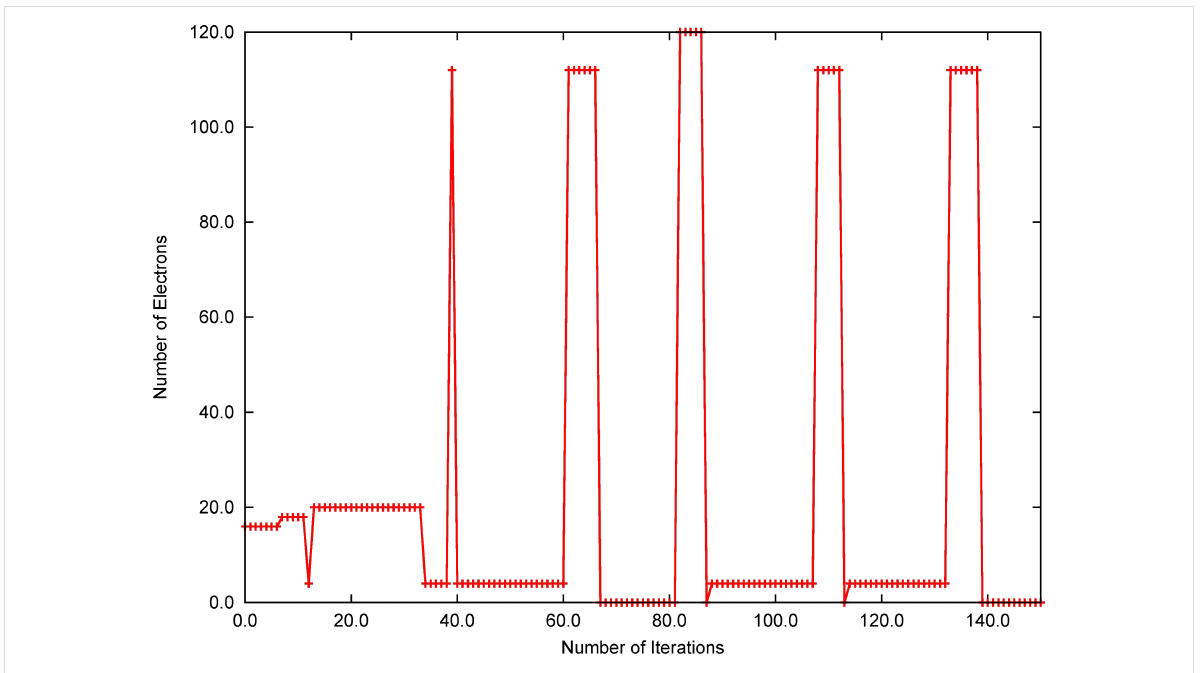
Figure 1: Evolution of the number of electrons with the number of iterations for O 2 if the potential dependent energy is computed by inserting the aspired μ into Equation